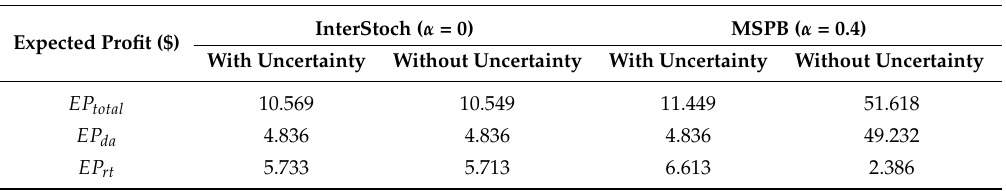
Table 6. Impact of uncertainty modeling on day-ahead, real time and total expected profits under the conservative